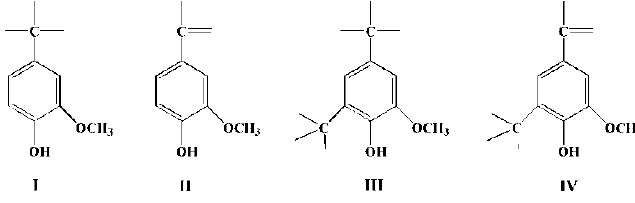
Figure 1. Structure of different types of phenolic hydroxyl.